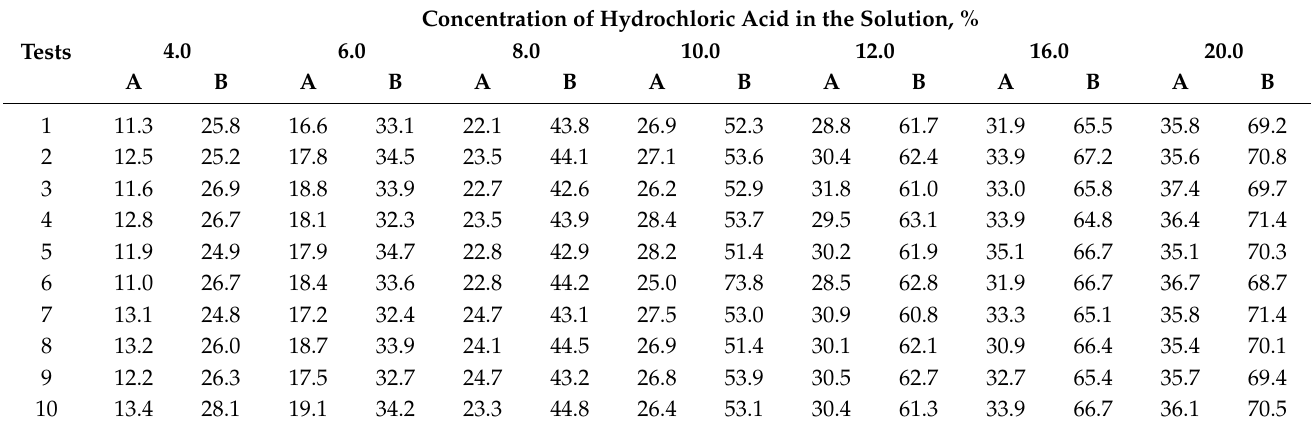
Table 7. Aluminum extraction (%) without mechanical activation (A) and with mechanical activation (B).